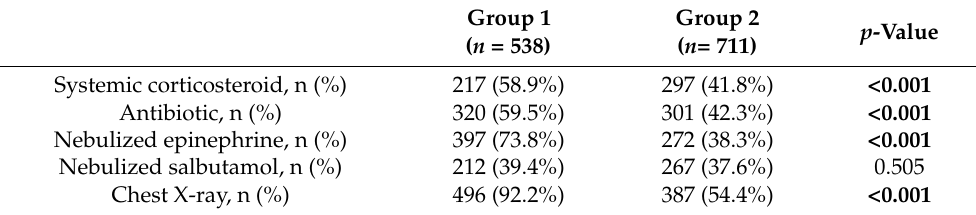
Table 4. Use of CXR and non-recommended pharmacotherapies in the different